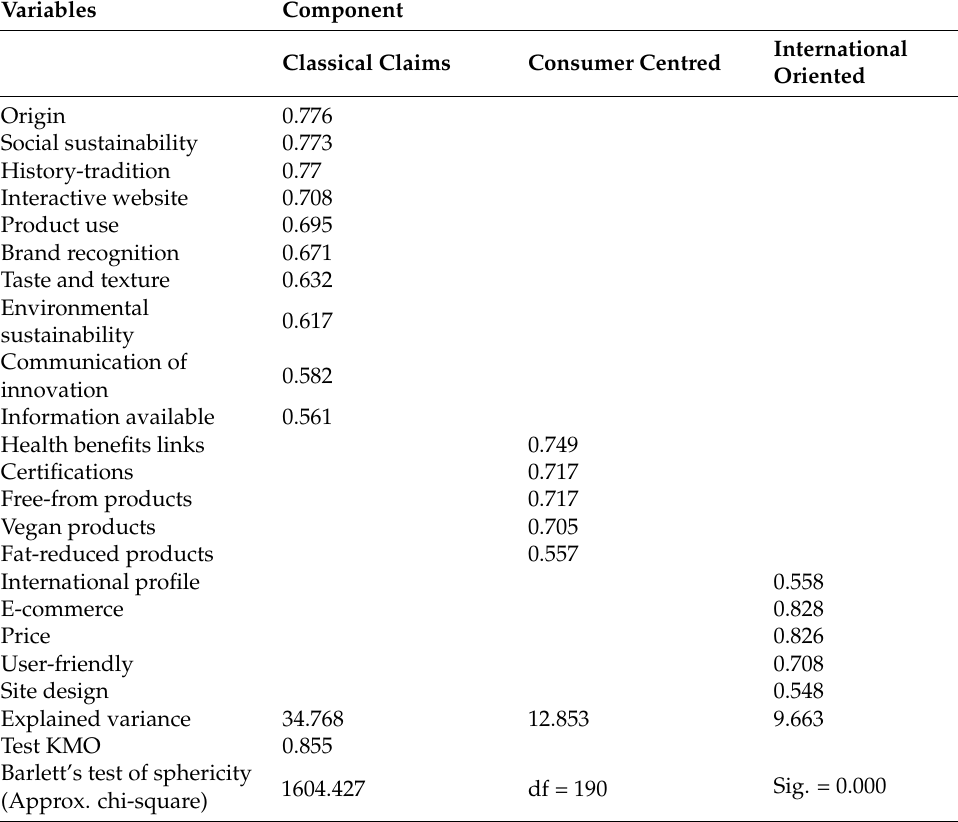
Table 3. PCA results: web-based communication styles of Piedmontese